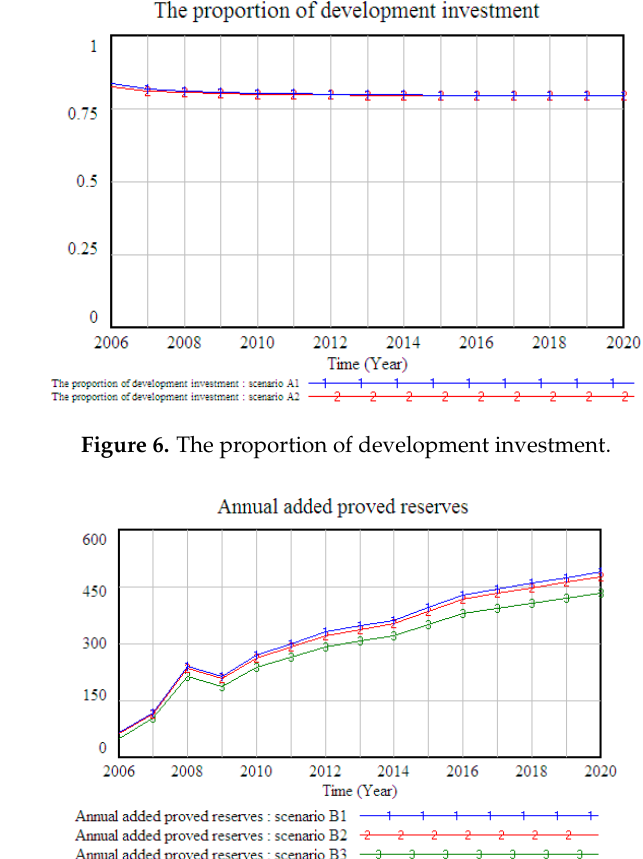
Figure 6. The proportion of development investment.